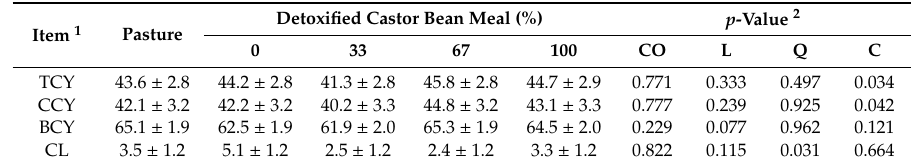
Table 7. Carcass yield (%) of lambs (mean ± SD) supplemented with or without castor bean meal via a creep-feeding method.